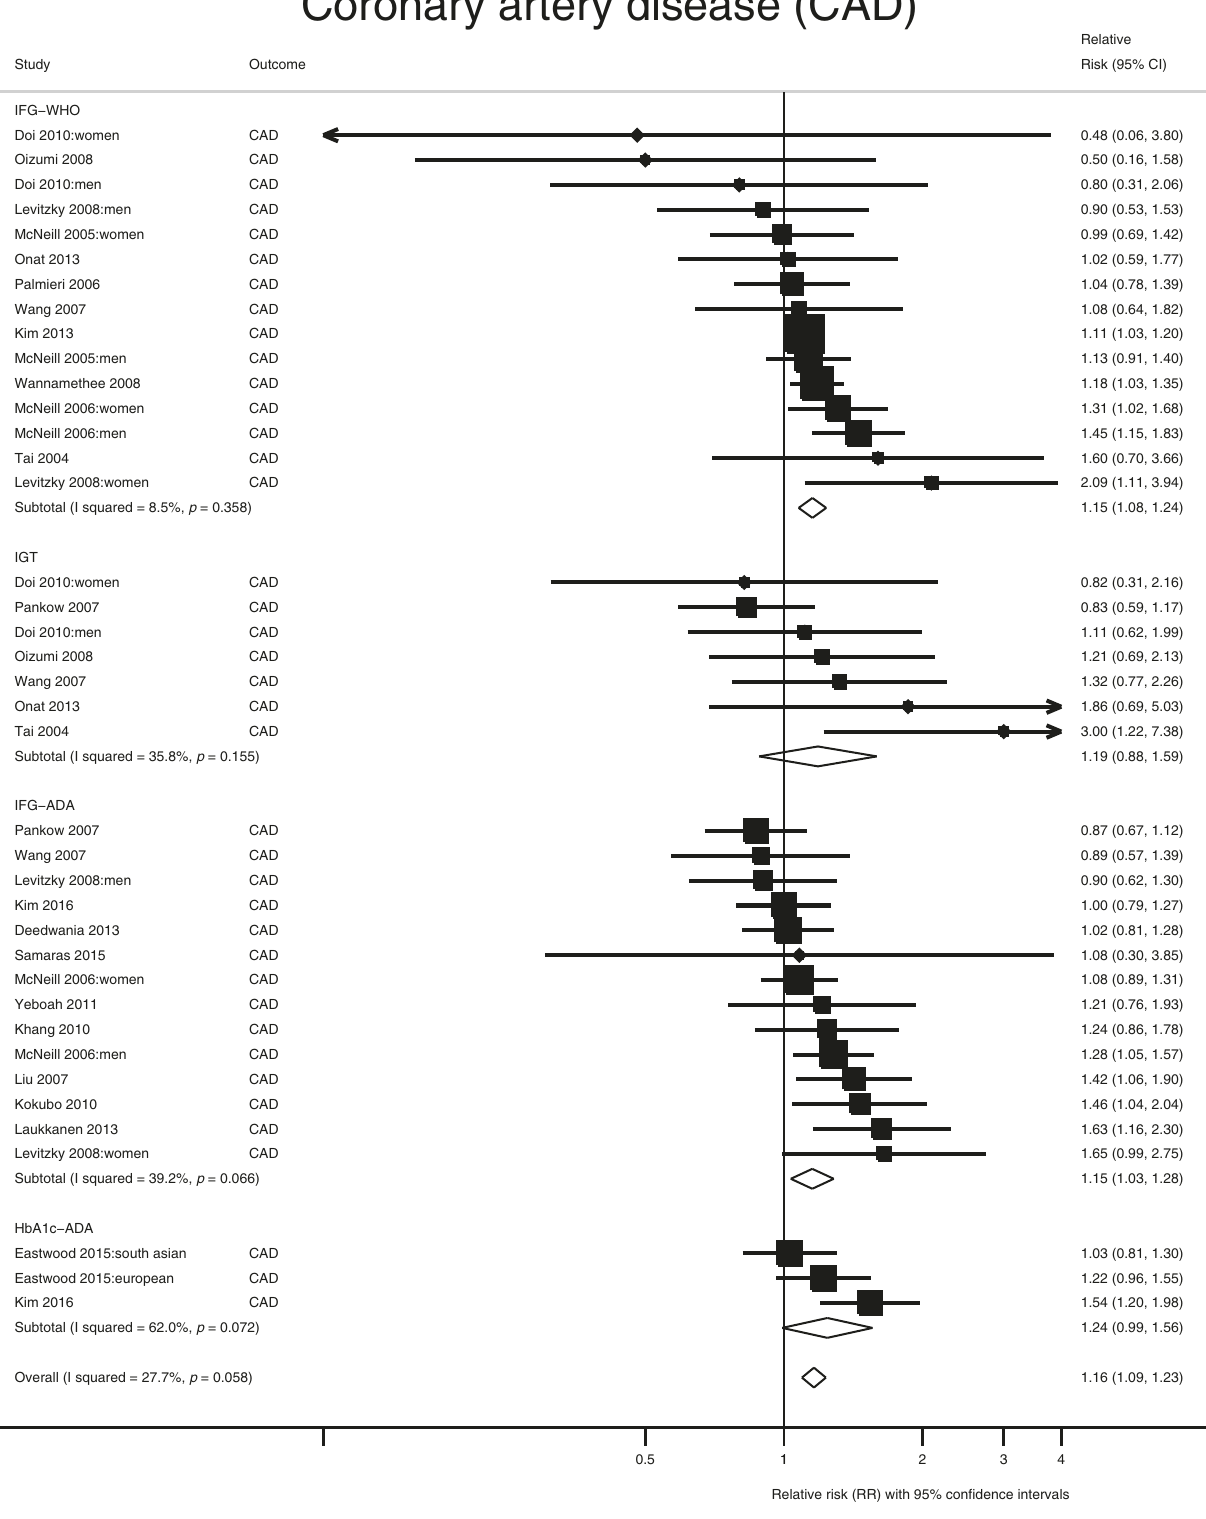
Fig. 1 Meta-analysis of the association between prediabetes and CAD. The square and diamond shapes represent effect size (relative risk estimates), while the horizontal bars represent the 95% con fi dence intervals. A total of 21 studies are included. All P values are two-sided. Source data are provided as Source Data fi